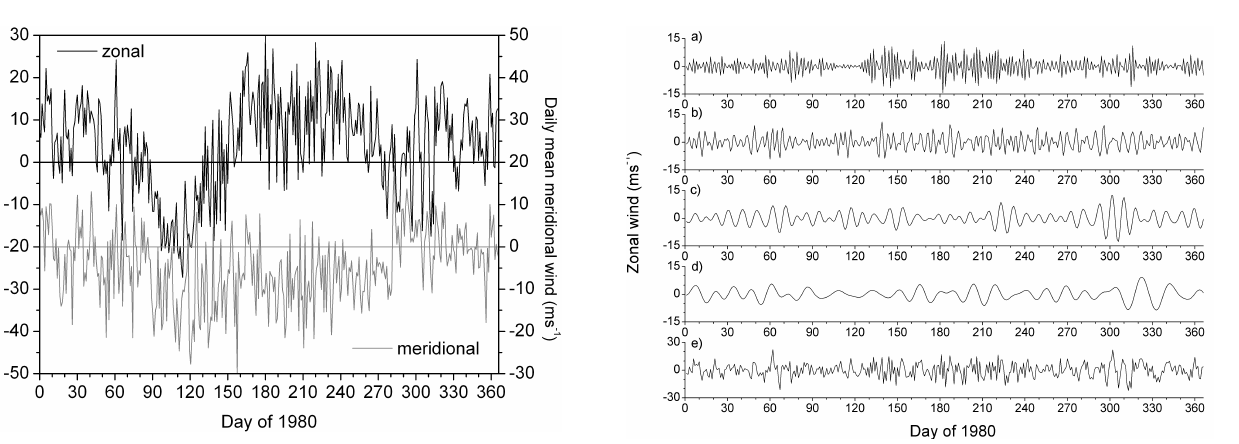
Fig. 2. Time series of filtered zonal winds in 1980 using different period bands (a) 2–3 days, (b) 3–7 days, (c) 7–12 days, (d) 12–30 days, (e) 2–30